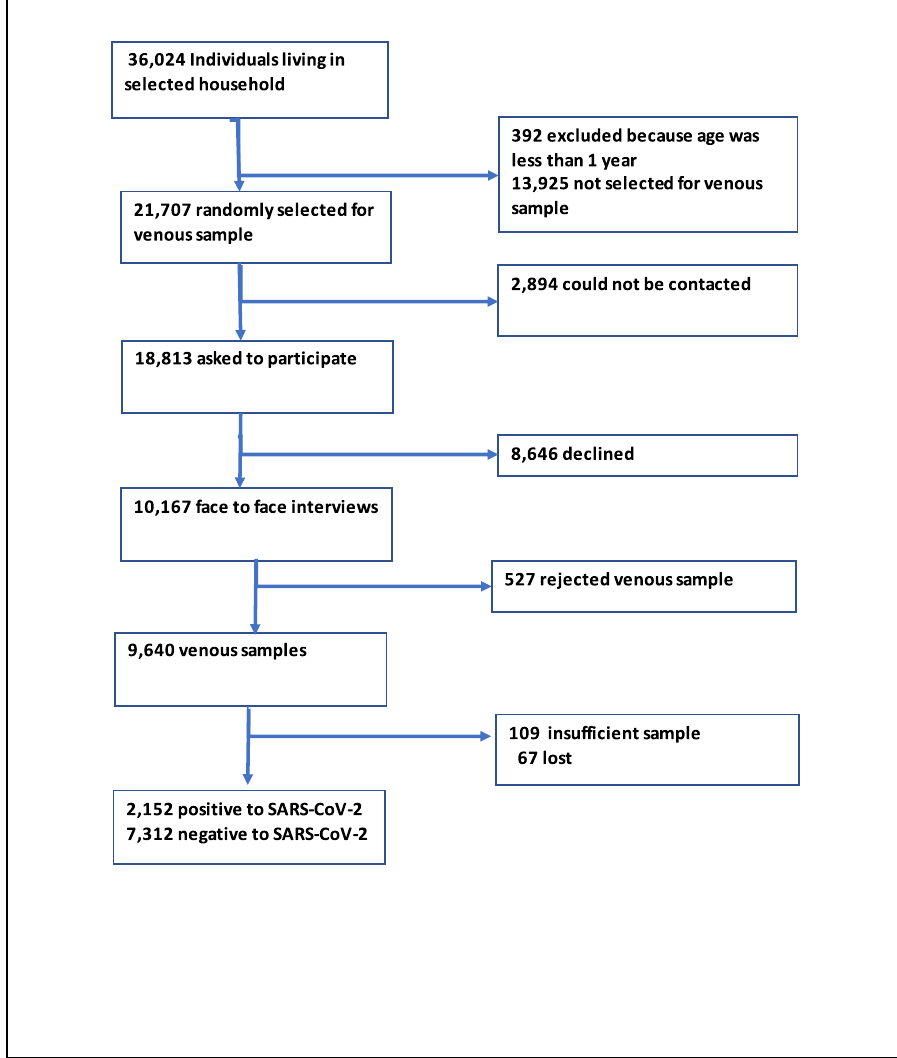
Fig. 2 Flowchart of participants in the serologic subsample in Ensanut 2020. The fl owchart of participants in the National Health and Nutrition Survey (Ensanut 2020). From the 36,024 subjects selected at the household level, a subsample of 21,707 were randomly selected to participate in the serologic sample. From those some could not be contacted and others declined to participate. We collected 9,640 venous